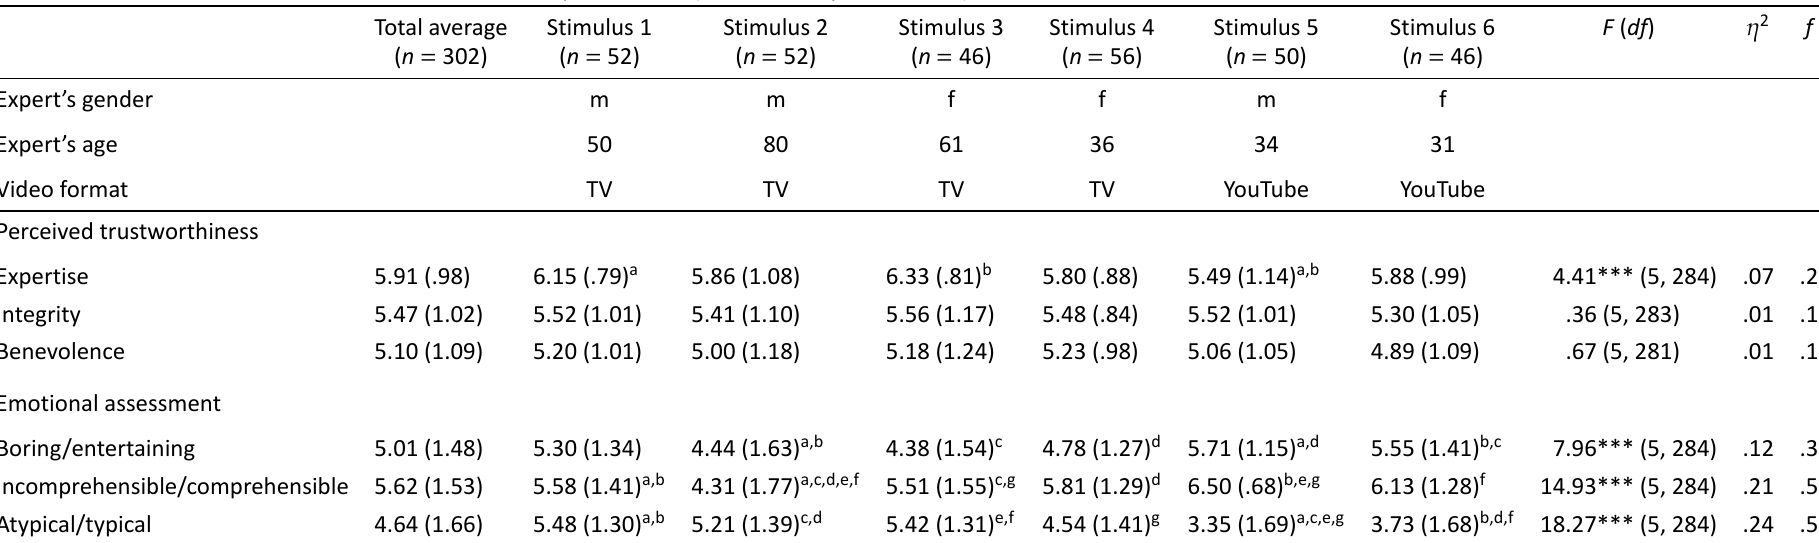
Table 4. Mean differences in the evaluation of scientists per stimulus (ANOVA with post-hoc